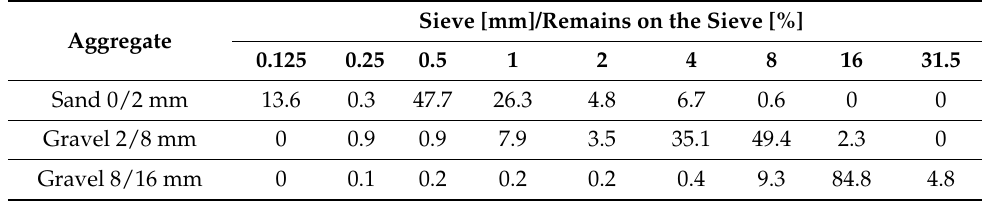
Table 1. Grain size distribution curves of the sand and gravel.